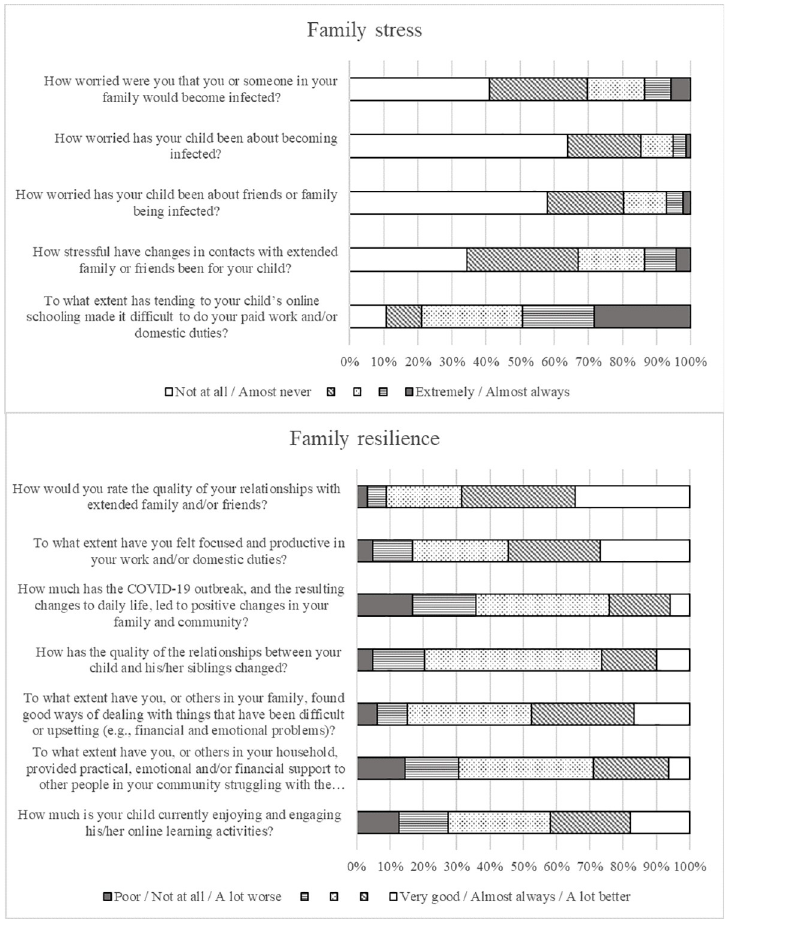
Fig 4. Maternal report of family stress and family resilience individual